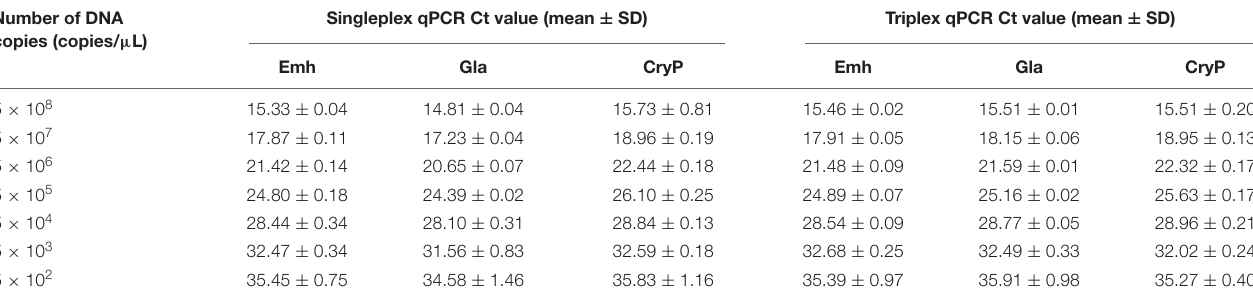
TABLE 3 | Limit of detection (LOD) and standard curves of singleplex and triplex quantitative PCR (qPCR) assays. Number of DNA copies (copies/ µ L)